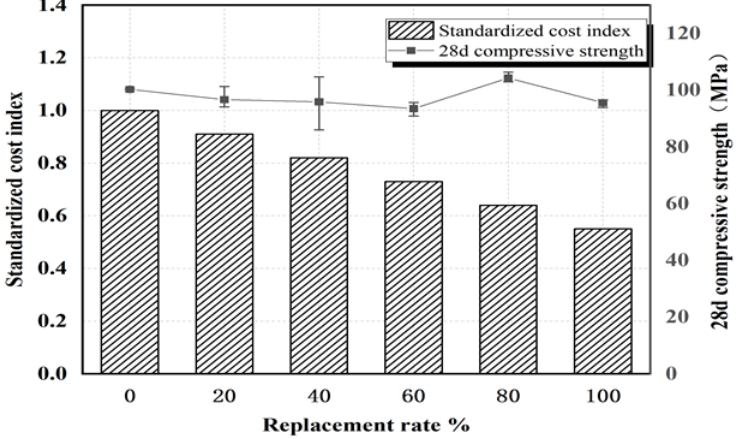
Figure 16. Comparison of standardized cost index and 28-day compressive strength for various sand replacement rates.